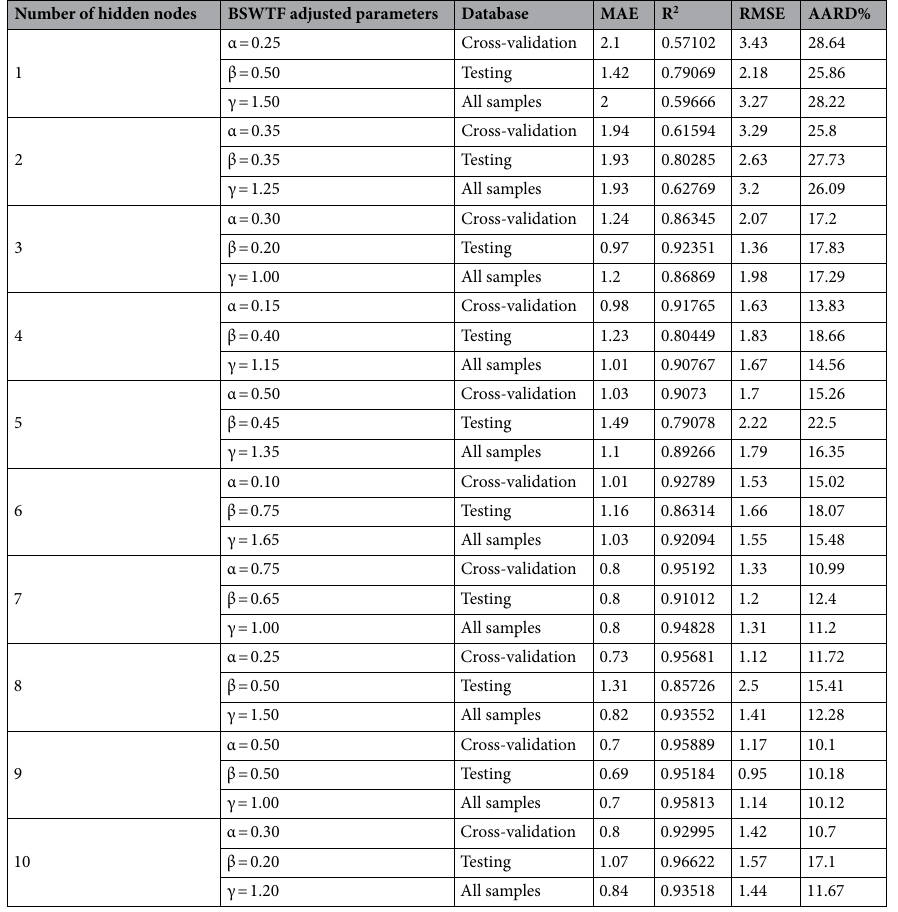
Table 2. The best results obtained by the different topologies of the wavelet neural